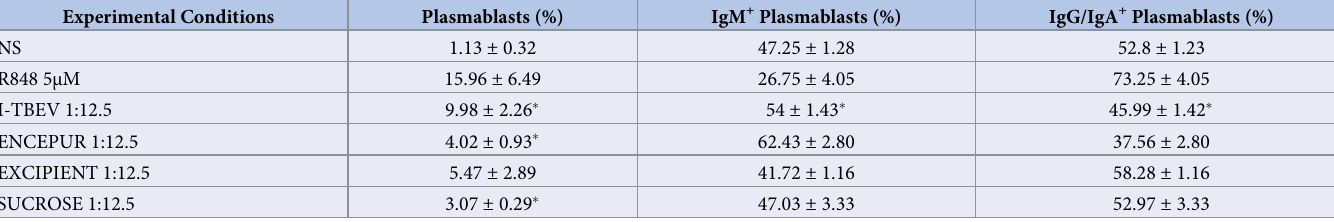
Peripheral blood mononuclear cells (PBMC) were stimulated with R848 (5 μ M), inactivated TBEV (I-TBEV), Encepur vaccine, excipient and sucrose (1:12.5) or left untreated (NS) for 10 days and the percentages of CD27 hi CD38 hi plasmablasts and IgM + or IgG/IgA + plasmablasts were measured by cytofluorimetric analysis. The results shown were mean relative values ± standard error of the mean of 5 independent experiments. ANOVA p value for plasmablast percentage: 0.018. ANOVA p value for IgM + plasmablast percentage: 0.022. ANOVA p value for IgA/IgG + plasmablast percentage: 0.031. Based on LSD (equivalent to no